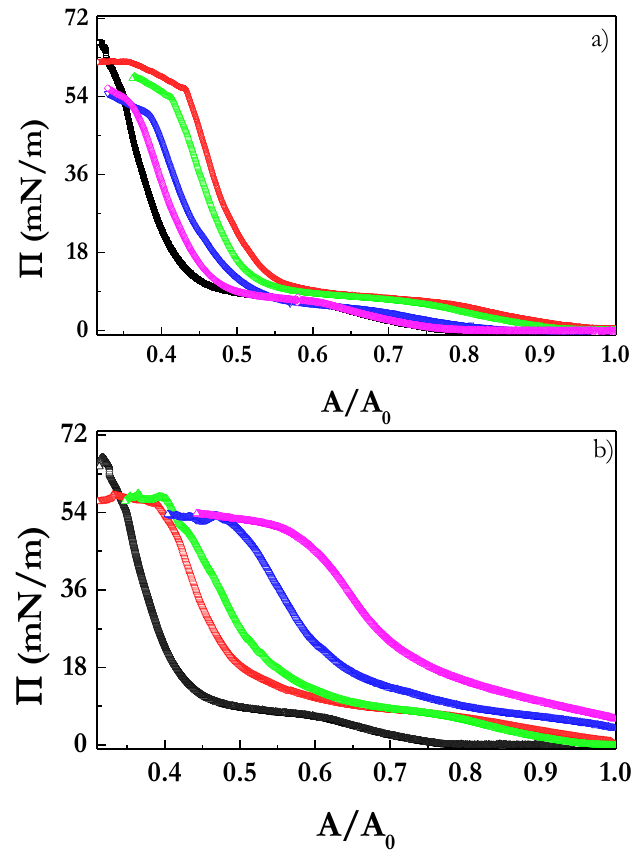
Figure 2. Π – A / A 0 isotherms for DPPC Langmuir monolayers upon the incorporation of different weight fraction of particles at the interface ( x p ): CB ( a ) and SiO ( b ). Each curve corresponds to DPPC monolayers with a different weight fraction of particles at the interface ( x p ): (Δ) 0.00, (Δ) 0.10, (Δ) 0.33, (Δ) 0.75, and (Δ) 0.90.